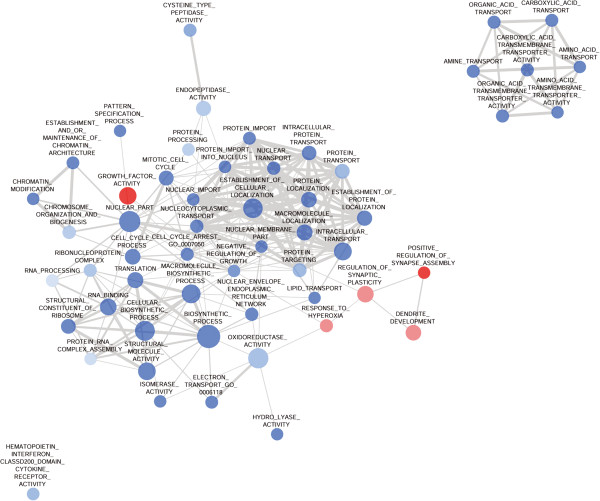
Network analysis of the GSEA results in the frontal cortex. The network shows significantly (nominal p < 0.05, false discovery rate < 0.25) enriched gene ontology (GO) terms in the gene set enrichment (GSEA) analysis in the frontal cortex (FC) of Dark Agouti rats 3 weeks after a single-dose (15 mg/kg, intraperitoneal) 3,4-methylenedioxymethamphetamine (MDMA) administration. Blue and red circles represent down- and upregulation of the associated GO terms, respectively. The size of the nodes is proportional with the number of genes in the GO term and the thickness of the grey edges represents the number of common genes between two GO terms, if any. Most of the processes in the FC were downregulated. The cellular biosynthetic process and establishment of cellular localization GO terms are in central positions of two different groups while chromosome and chromatin organization, and transmembrane transport processes form the third and fourth group of tightly related, downregulated gene sets. These alterations suggest a general neurotoxic effect while the upregulation of gene sets related to synapse formation raises the possibility of a parallel running recovery process. The expression of the only immunologically related GO term was attenuated. See text for further details.